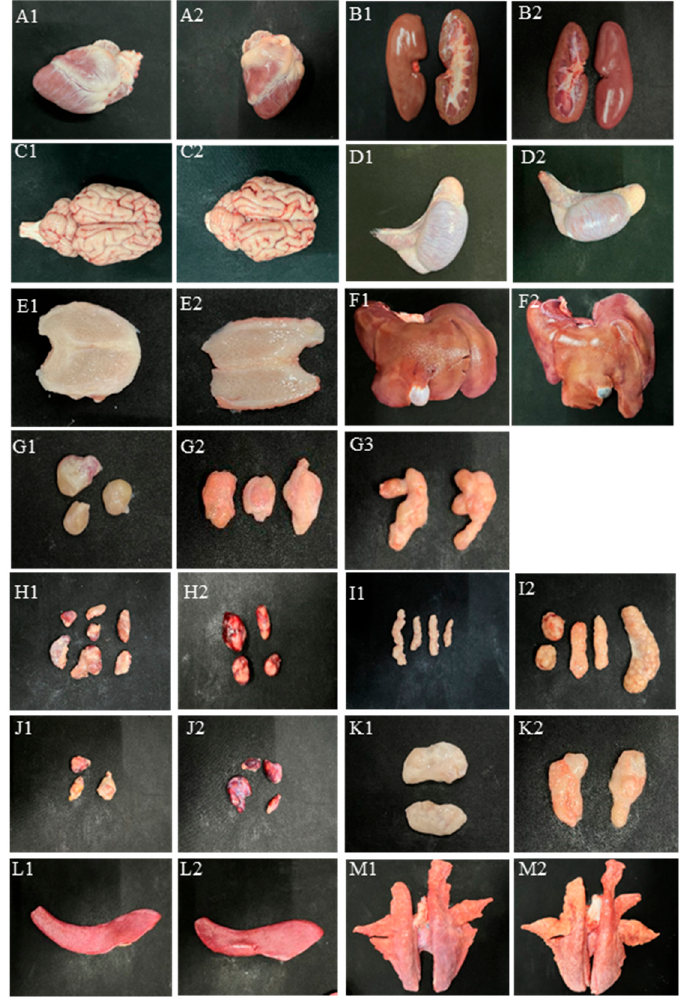
Figure 2. The gross lesions of hearts ( A1 , A2 ), kidneys ( B1 , B2 ), brains ( C1 , C2 ), testis ( D1 , D2 ), tonsil ( E1 , E2 ), livers ( F1 , F2 ), submaxillary lymph node ( G1 – G3 ), hilar lymph node ( H1 , H2 ), mesenteric lymph node ( I1 , I2 ), liver portal lymph node ( J1 , J2 ), inguinal lymph node ( K1 , K2 ), spleen ( L1 , L2 ), and lung ( M1 , M2 ). The number 1 means control group, other numbers represent the PCV3-inoculated group.